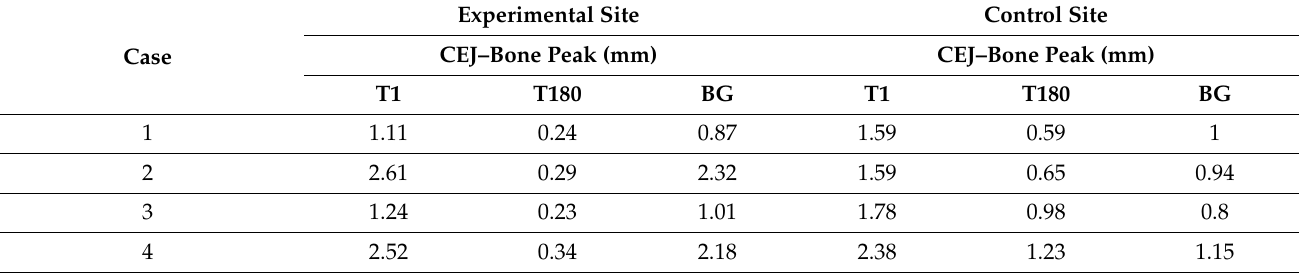
Table 2. Radiographic measurements from distal point of M2’s CEJ to bone peak (mm) at T1 and T180. Bone gain (BG). Mean values of distance in